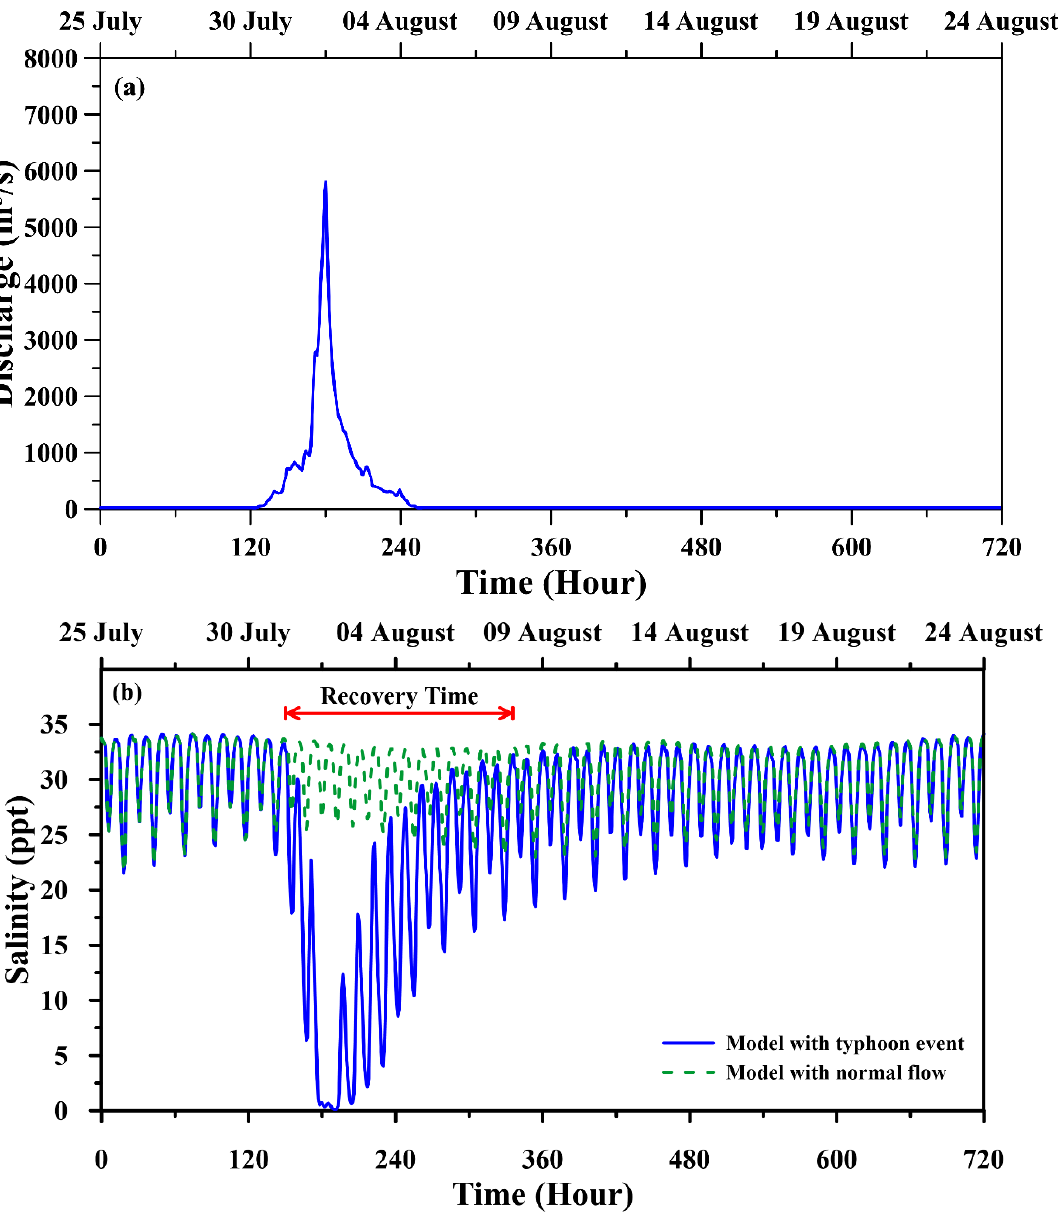
Figure 6. ( a ) Total freshwater discharge inputs from the upstream reaches of the Dahan River, Xindian River, and Keelung River during Typhoon Saola in 2012, and ( b ) time series salinity responses at the Danshuei River mouth to typhoon events (high flow) and normal flow conditions.